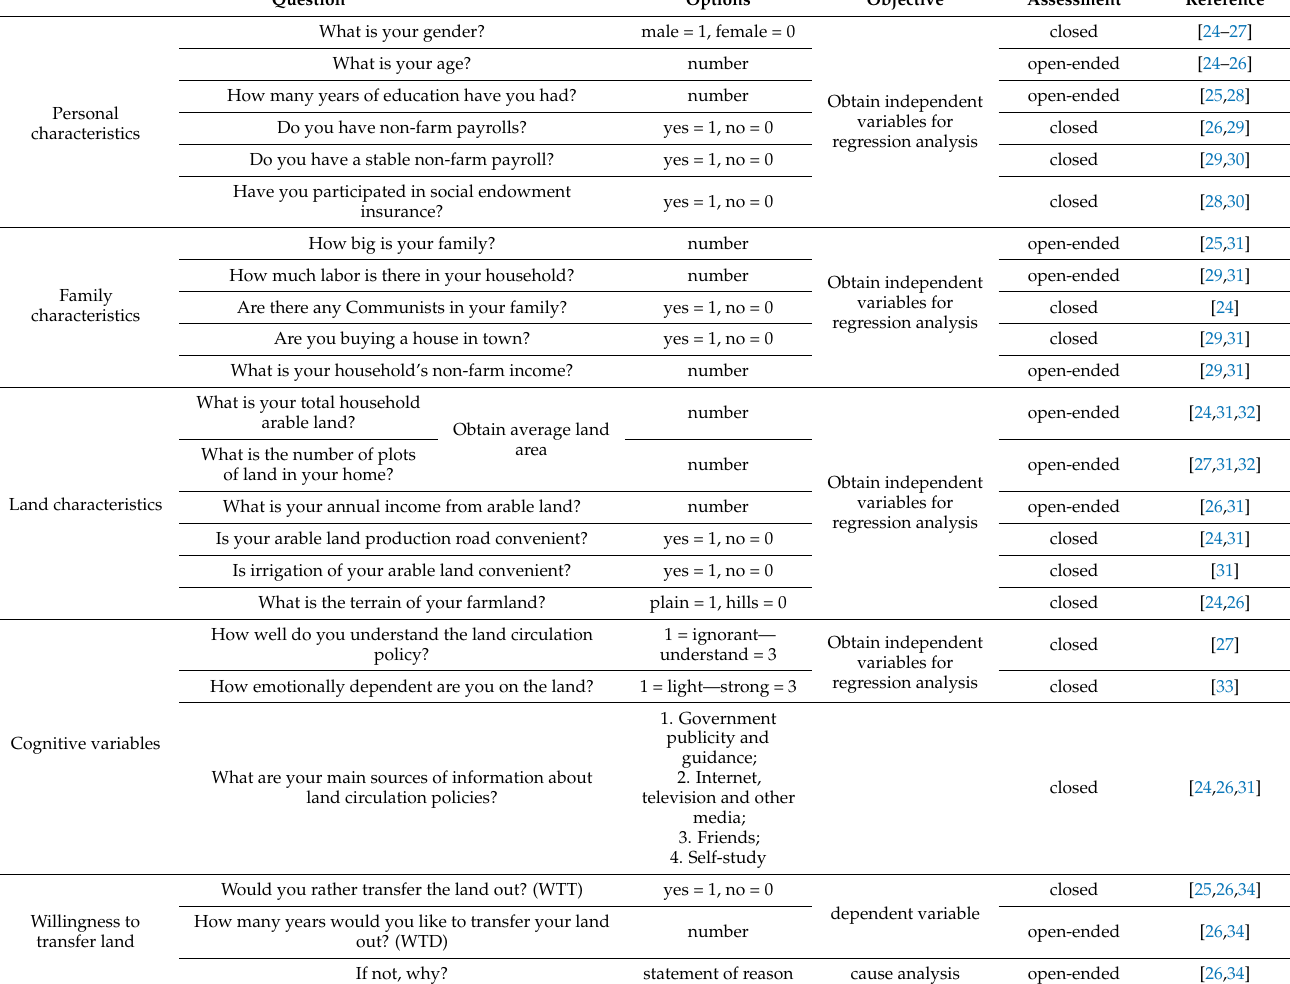
Table 1. Questionnaire design and